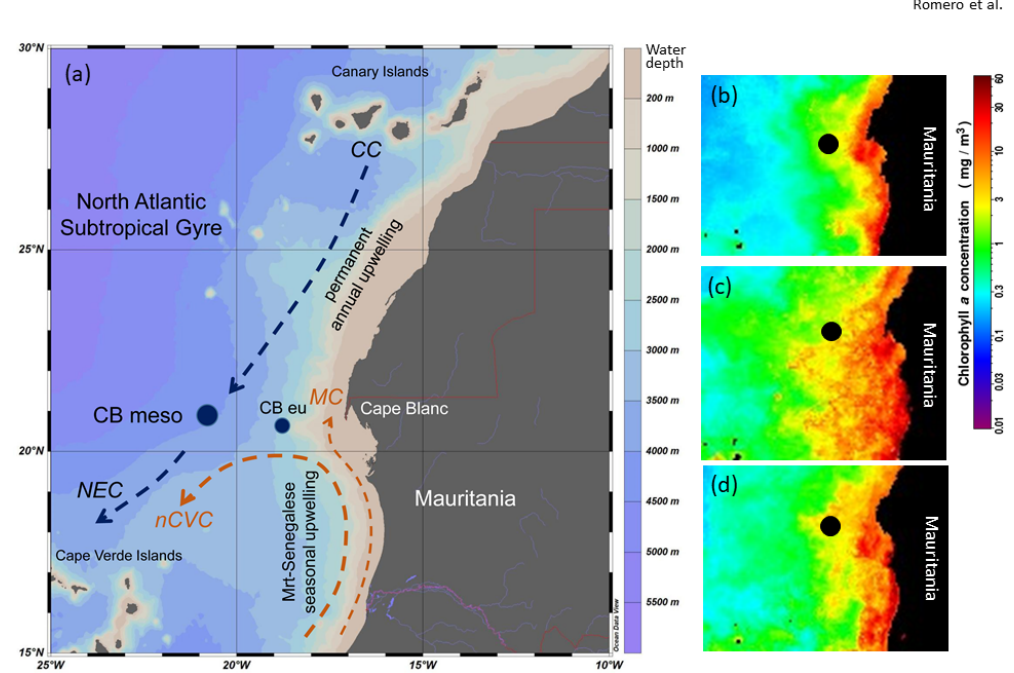
Figure 1. (a) Map of the study area showing the locations of the sediment trap sites CBmeso and CBeu (dark blue dots). Major surface currents are also shown (Canary Current: CC; Mauritanian Current: MC; North Equatorial Current: NEC; north Cabo Verde Current: nCVC). The upwelling zones along the northwestern African margin are depicted after Cropper et al. (2014). The color scale (right-hand side) refers to meters below surface water (0m). (b–d) Satellite-gained images of average winter concentration of chlorophyll a in surface waters along the northwestern African margin. The images depict chlorophyll a values in winters 1997, 2002, and 2008, gained with SeaWIFs ( b , 1997) and MODIS ( c and d , 2002 and 2008; https://oceancolor.gsfc.nasa.gov/cgi/l3, last access: 31 July 2020). Note the high interannual variability of chl a concentration. For interpretation of the references to color in this figure legend, the reader is referred to the web version of this